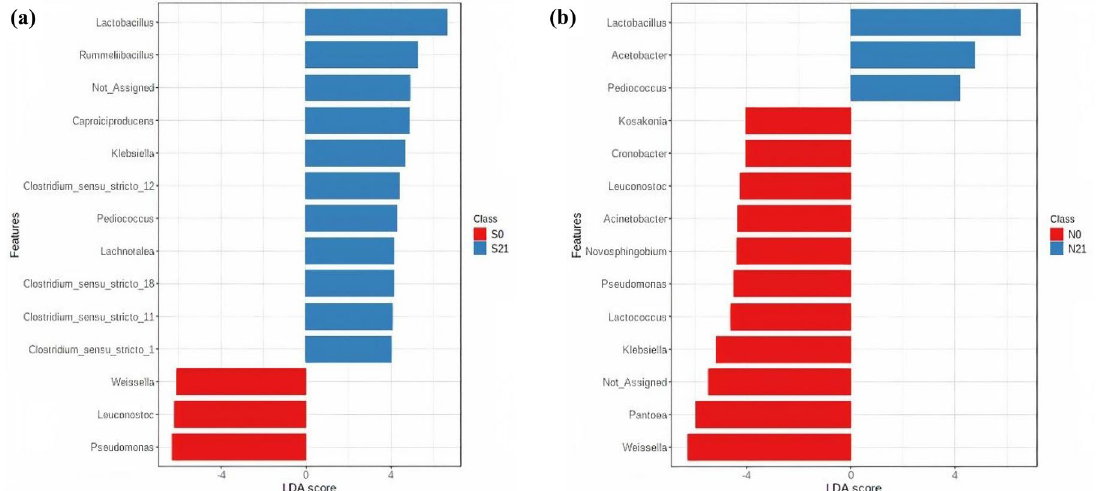
Figure 5. Graphics of linear discriminant analysis (LDA) effect size (LEfSe) between fresh forage and silage, (a) sweet corn and (b) Napier, at genus level. Red indicates fresh forage and blue for silage. The threshold on the logarithmic LDA score for discriminative features was set to 4.0 at p -value < 0.05 (original p -value for sweet corn and FDR-adjusted for Napier) (S0, Fresh sweet corn; S21, Sweet corn silage; N0, Fresh Napier; N21, Napier